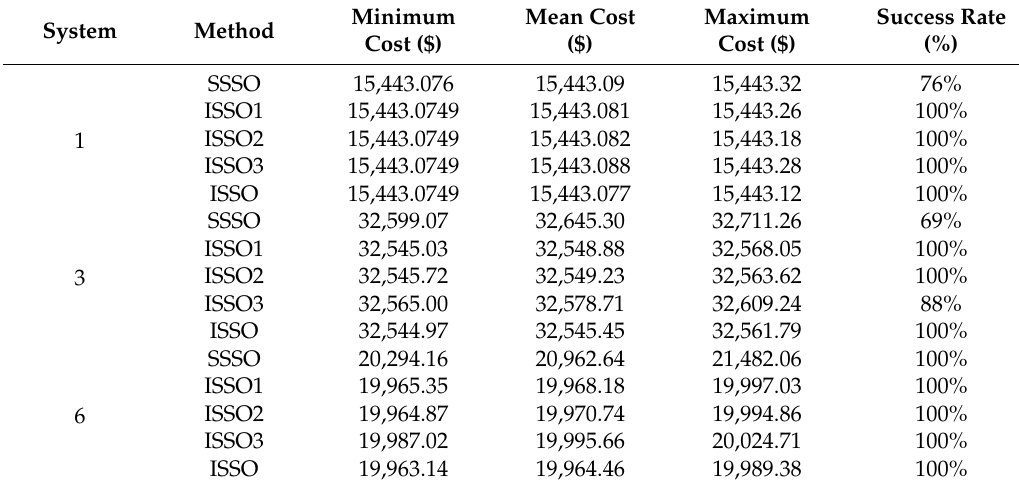
Table 2. Results obtained by ISSO and other versions of SSSO for three systems 1, 3 and